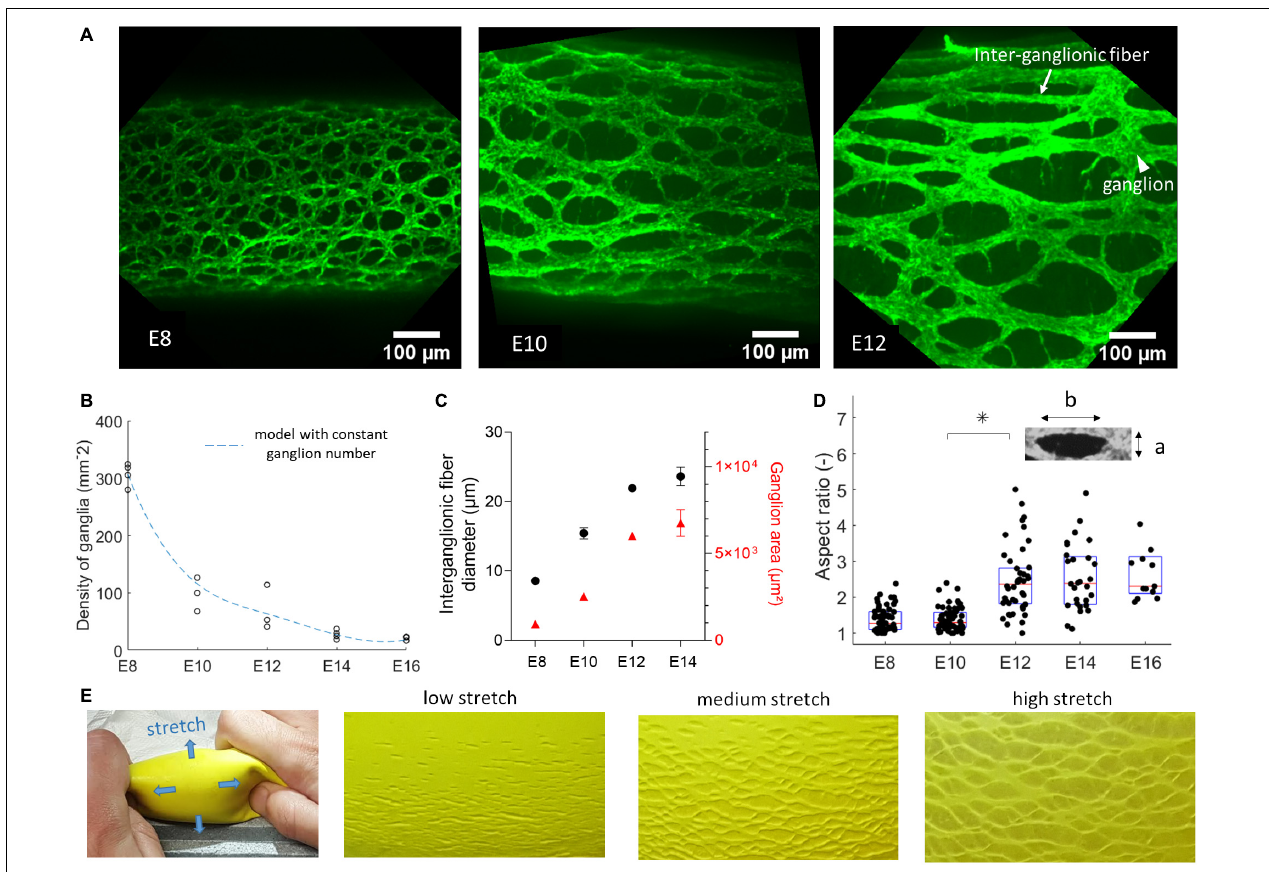
FIGURE 1 | Fetal development of the chicken enteric nervous system. (A) Wholemount immunolabeling with Tuj1 antibody against β III-tubulin showing the evolution from E8 to E12 of the neuronal network of the ENS in the duodenum, same scale images. The rostro-caudal axis is horizontal in all images. (B) Experimental evolution of the number of ganglia per mm 2 in the duodenum, one dot per sample, sample numbers are E8 n = 4, E10 n = 3, E12 n = 3, E14 n = 4, E16 n = 3. Dashed blue line: model prediction assuming total number of ganglia is set at E8. (C) Inter-ganglionic fiber diameter (black, left axis) and average ganglion area (red, right axis), n = 3 different guts for each age, error bar length is SD, when no error bar is visible it is smaller than dot size. For each sample, the dimensions of n = 6 fibers and ganglia were measured and averaged. (D) Aspect ratio b/a (inset) of inter-ganglionic spaces, one dot per inter-ganglionic space analyzed. (E) A gel surrounded by a rubber membrane is pressurized, causing stretch along the blue arrows. At low stretch, defects (small cracks) in the rubber are small and dense. As the membrane stretches out, the cracks move apart but their total number does not change, providing a visual analogy to chicken fetal ENS